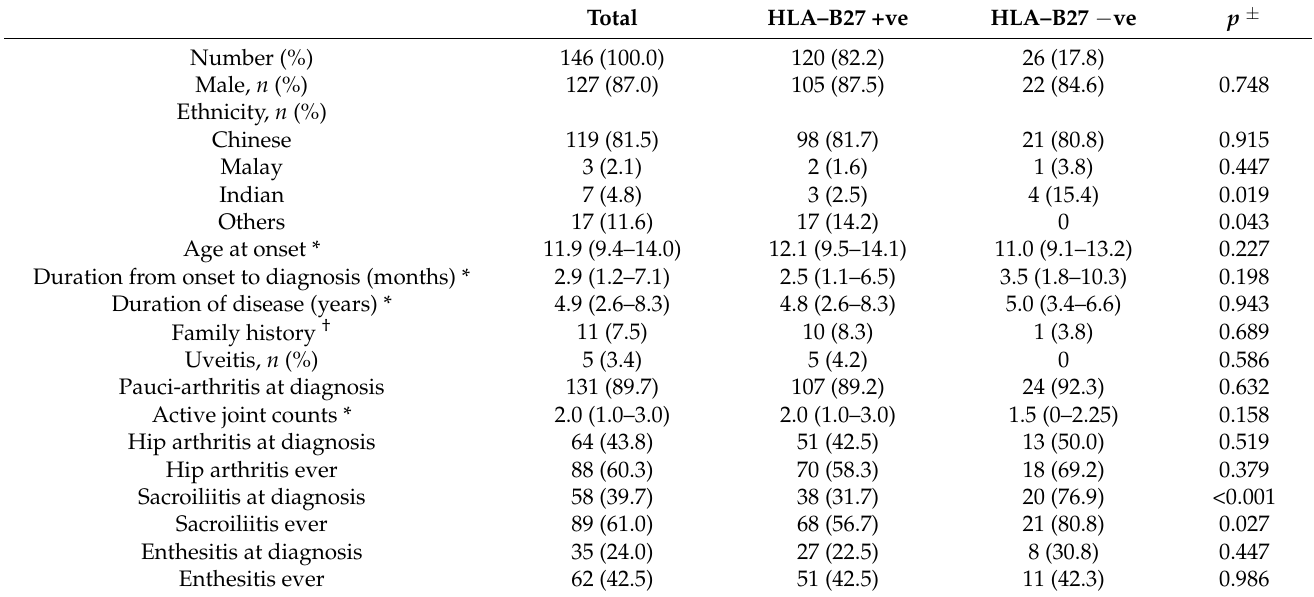
Table 1. Patient clinical characteristics and treatment by Human Leukocyte Antigen (HLA)-B27